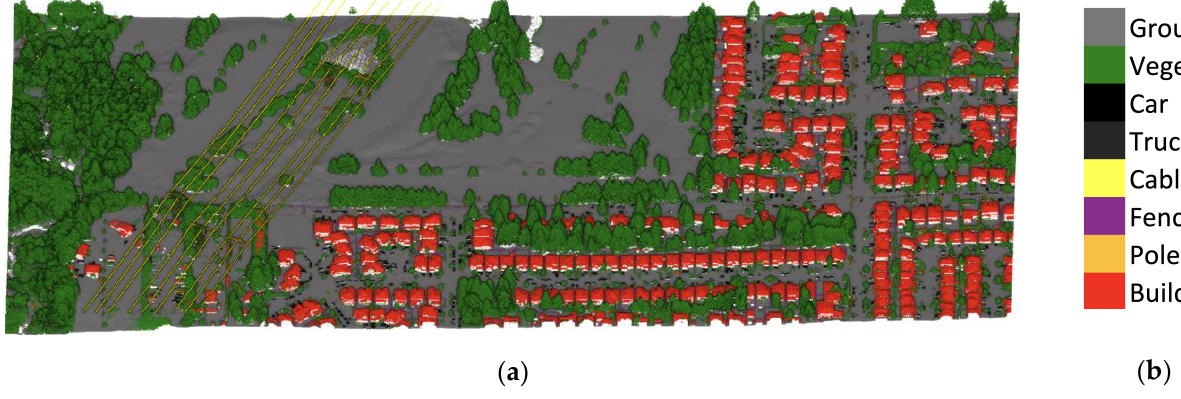
Figure 14. ( a ) Classification result of both DALES tiles with our 3DCNN, ( b ) legend. Table 9. Average and weighted F1 and IoU scores for 2DCNN and 3DCNN classifiers for the LASDU dataset. The OA is also reported.